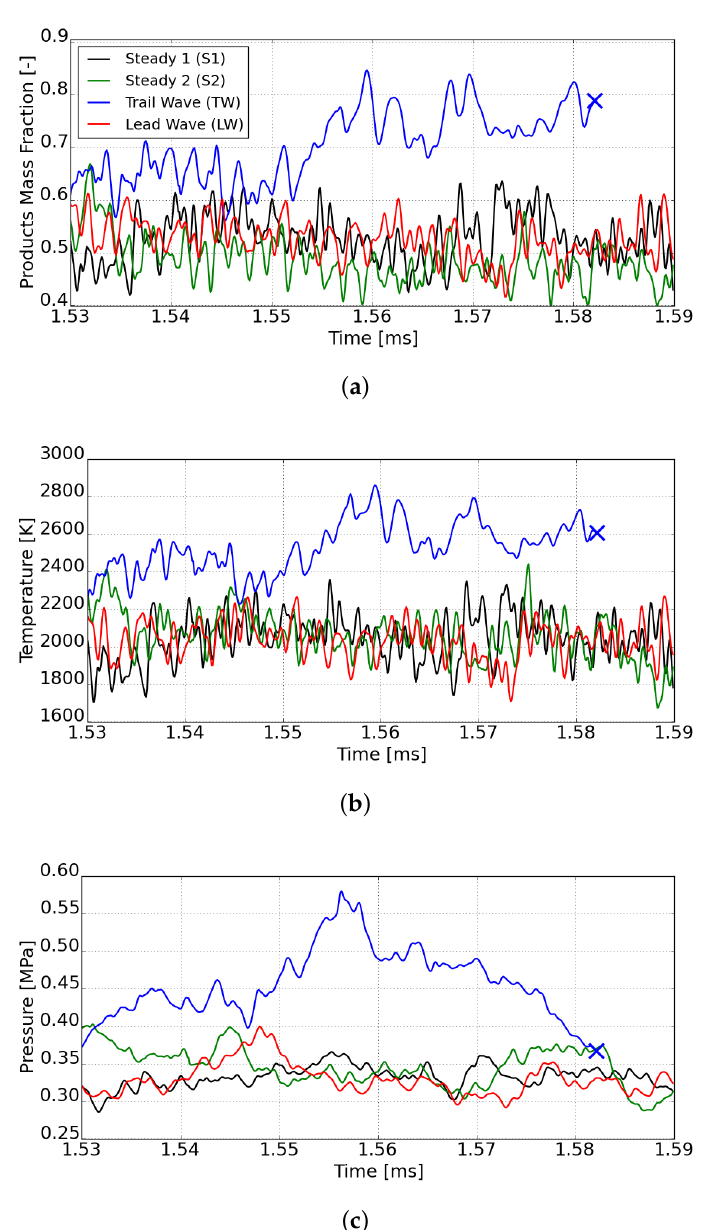
Figure 16. Local integrated regions upstream of each relative detonation wave: ( a ) products mass fraction, ( b ) temperature, and ( c )